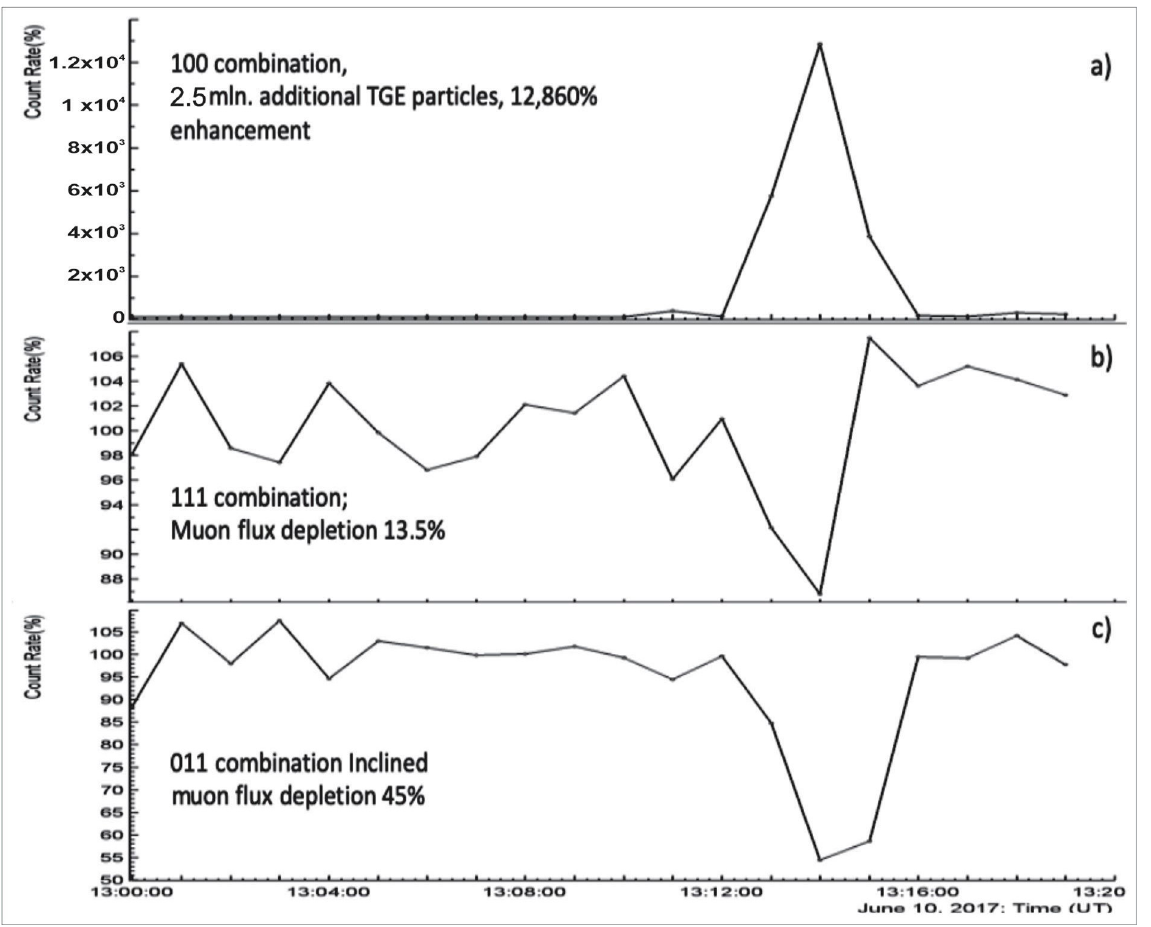
Figure 19. Extreme TGE event detected by SEVAN detector located on Lomnicky Stit: ( a ) TGE particles—electrons and gamma rays; ( b ) high energy muons; ( c ) inclined muons.